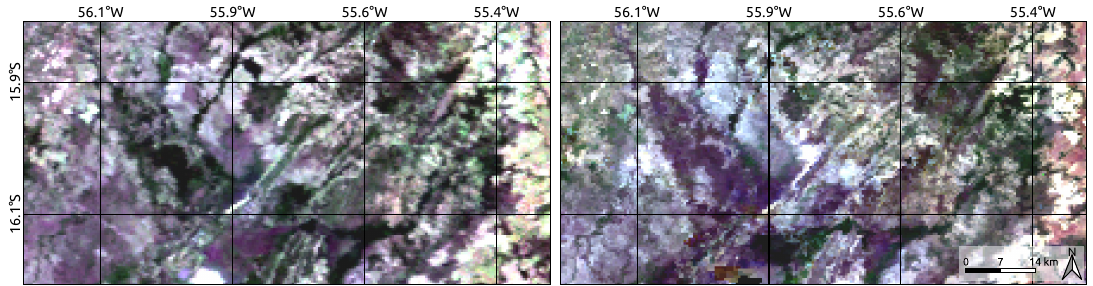
Figure 5. Reference image ( left ) and the later instant ( right —15 October 2020) for Area 3. Representa- tions in natural color composition.